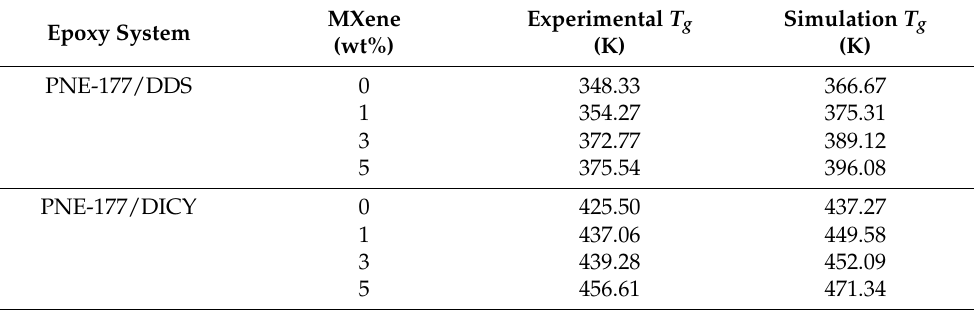
Figure 12. The density vs. temperature curves of MXene/epoxy resin based on MD simulations: ( a ) PNE-177/DDS and ( b ) PNE-177/DICY. Table 4. The experimentally measured and MD simulated T g values of PNE-177/DDS and PNE- 177/DICY systems.